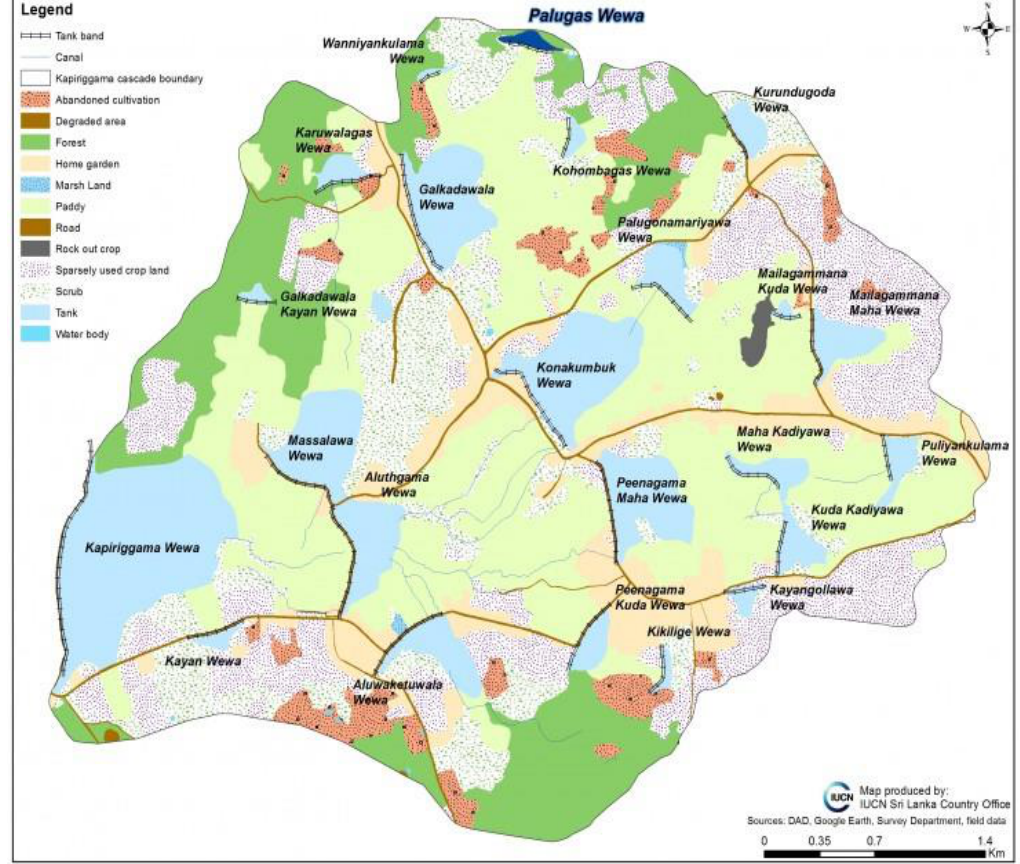
Figure 4. Layout of the Palugaswewa tank cascade system in Anuradhapura District (reproduced courtesy of the International Union for Conservation of Nature (IUCN) in Sri Lanka).